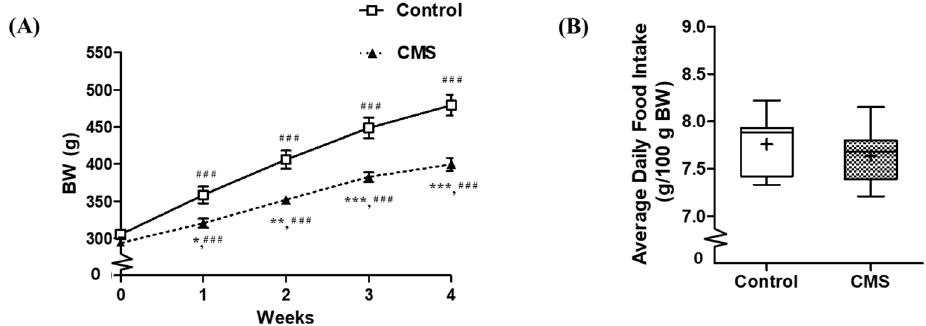
Figure 2. Body weight ( A ) and average daily food intake ( B ) of control and CMS. * p < 0.05; ** p < 0.01; *** p < 0.001 vs. control at the same time point, ### p < 0.001 vs. baseline (week 0) within group, two ‐ way repeated measures ANOVA followed by Dunnett’s; n = 7 for each